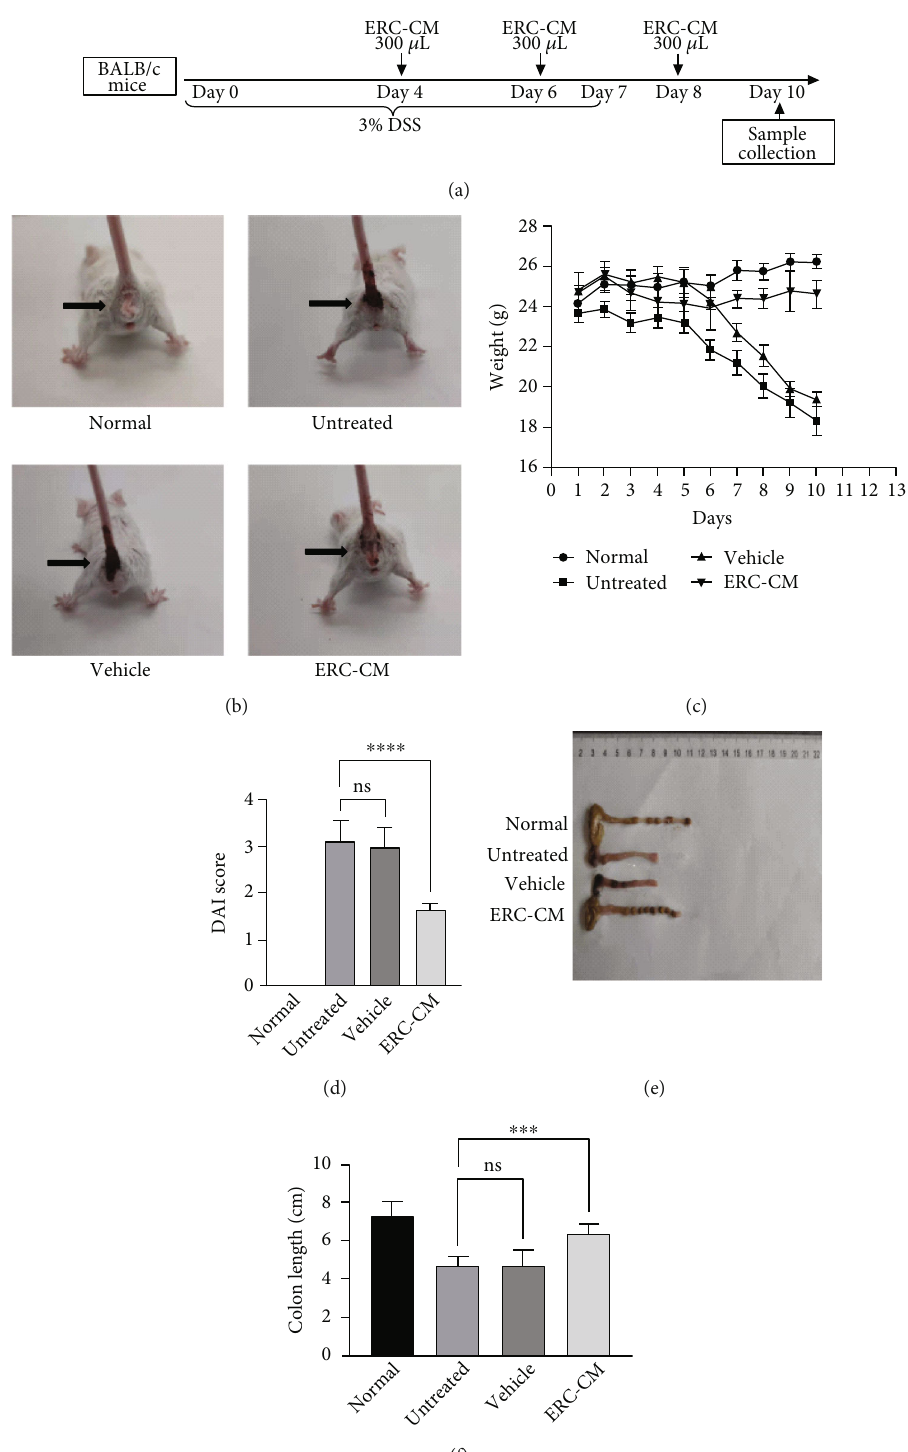
Figure 1: ERC-CM attenuated symptoms in DSS-induced experimental colitis. (a) Study design for the whole process of DSS-induced colitis and interventions. (b) Representative pictures showing bloody stool were taken on the 10th day after DSS induction. The mice in the ERC- CM group were in the best condition than those in other groups. Body weight changes (c) and DAI score (d) of each group of mice were recorded daily. In the ERC-CM group, the weight loss and DAI score were shown lesser than those in other groups. The length of the colon (e, f) in each group was measured and analyzed on day 10 ( n = 6 ). Data shown were representative, and the p value was determined by one-way ANOVA. ∗ p < 0 : 05 , ∗∗ p < 0 : 01 , ∗∗∗ p < 0 : 001 , and ∗∗∗∗ p < 0 : 0001